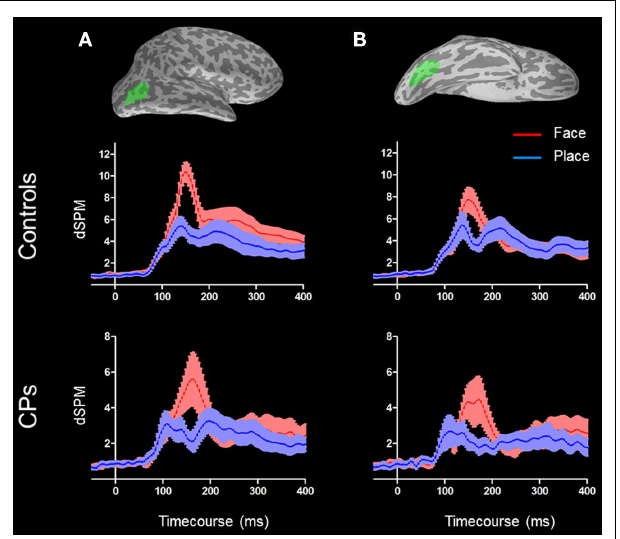
FIGURE 2 | Right lateral occipital area [(A) top] and rFG [(B) top] are shown in green on an inflated surface of a subject. M170 activity for both controls [ (A,B) middle] and CPs [ (A , B) bottom] are represented. Face activity (red) is higher than place activity (blue) in both groups and in both ROIs. For both conditions, the shades around the mean activity represent the